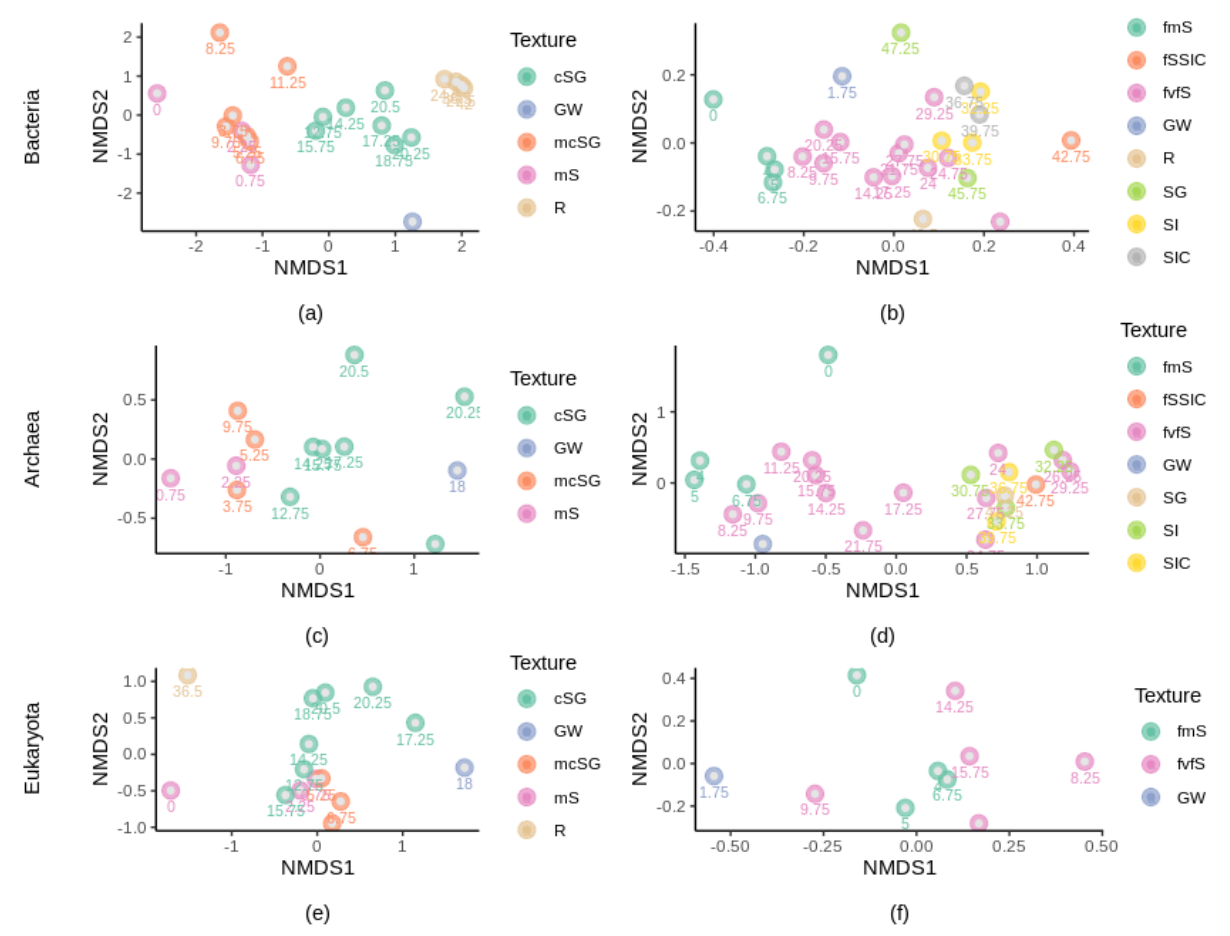
Figure 5. Ordination of microbial communities in the subsurface layers with different textures as indicated by nonmetric multidimensional scaling plots (nMDS) based on Bray–Curtis dissimilarity matrices. Textures are color coded, and depth is indicated for each sample (subscript). With: ( a ) bacterial composition at site 1, stress = 0.113; ( b ), bacterial composition at site 2, stress = 0.159; ( c )